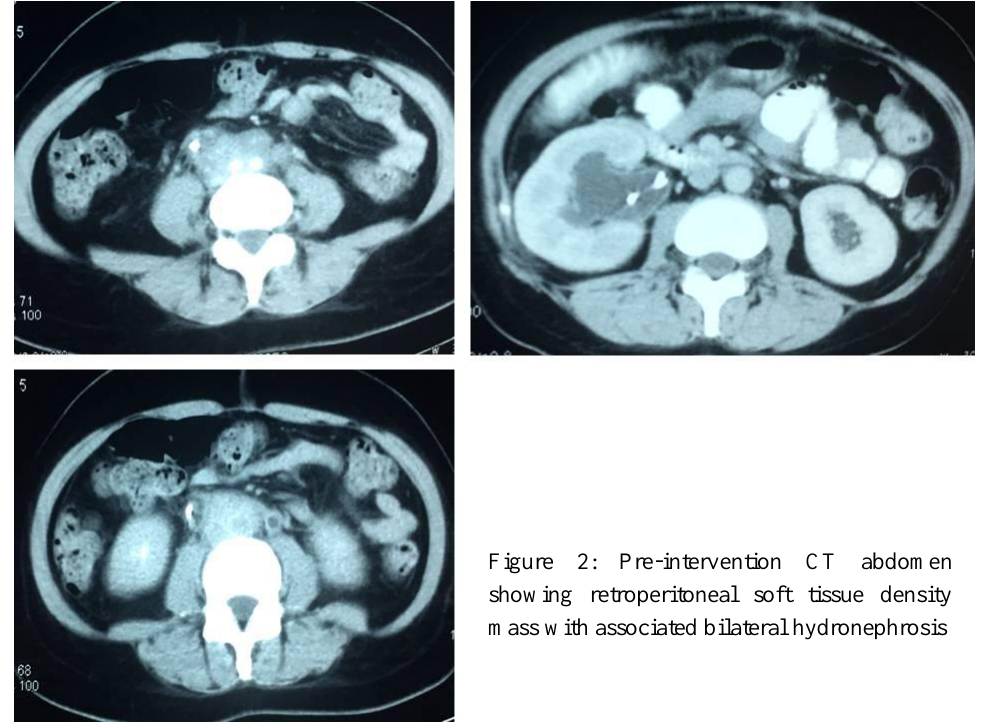
Figure 2: Pre-intervention CT abdomen showing retroperitoneal soft tissue density mass with associated bilateral